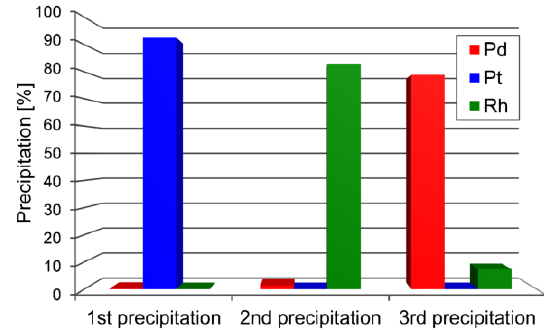
Figure 4. Mutual separation of Pd(II), Pt(IV), and Rh(III) from a 1.0 M HCl solution containing Pd(II), Pt(IV), and Rh(III) (1 mM each).